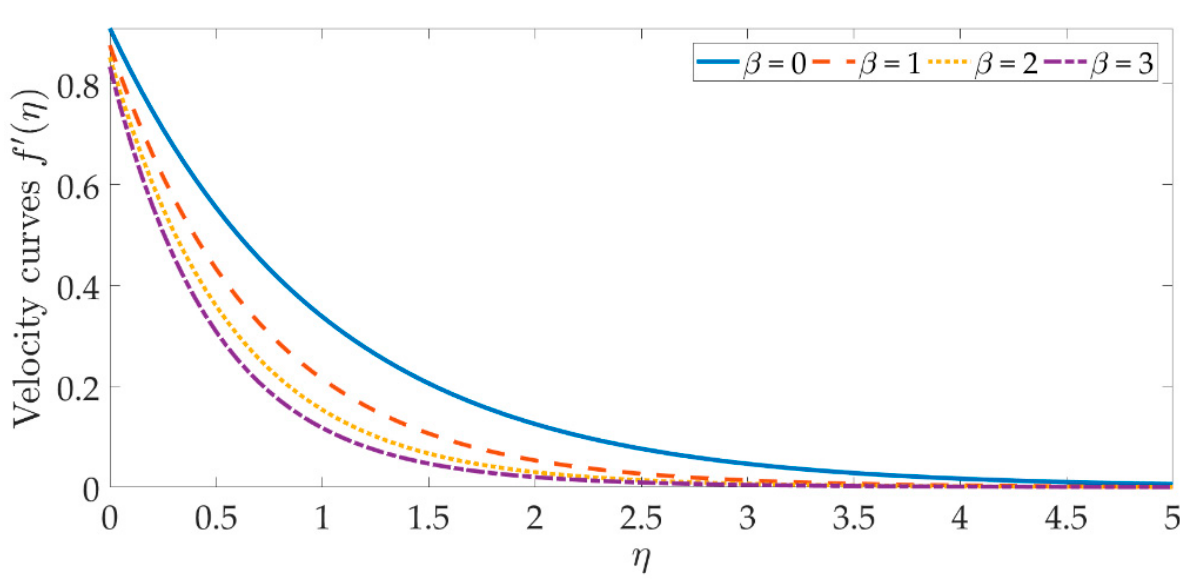
Figure 2. Velocity curves against the multiple values of β.